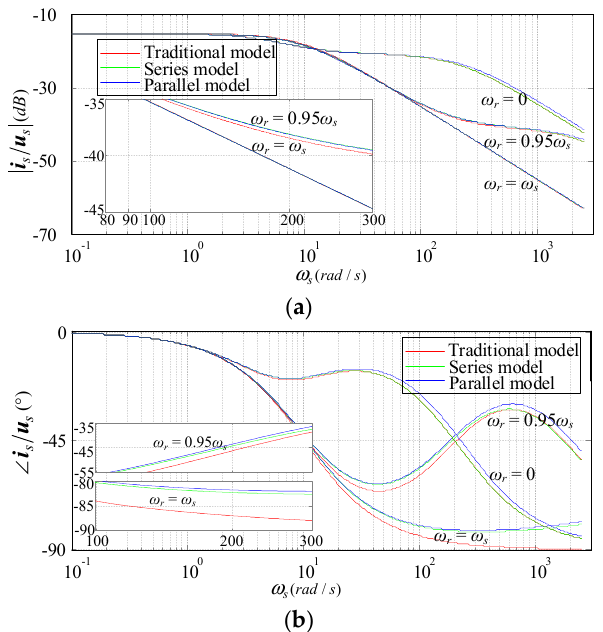
Figure 2. Bode plot of driving point admittance function. ( a ) Magnitude-frequency characteristic; ( b ) Phase-frequency characteristic.